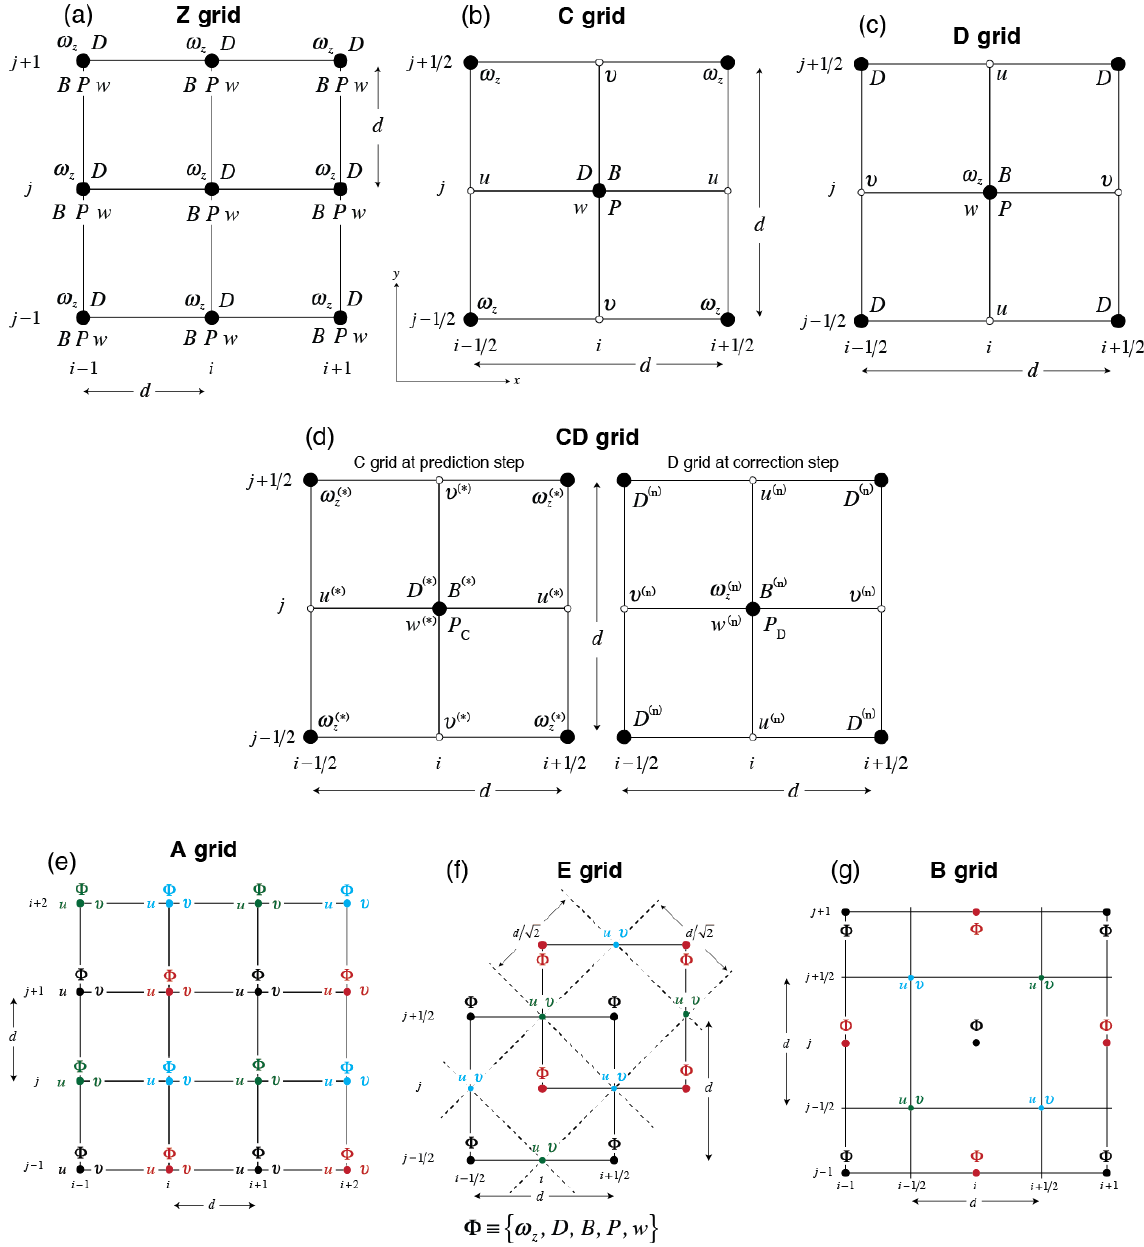
Figure 1. Portions of the (a) Z, (b) C, (c) D, (d) CD, (e) A, (f) E and (g) B grids on a square grid. Colored grid points in A, E and B grids indicate the network of grid points on which the decoupled solutions